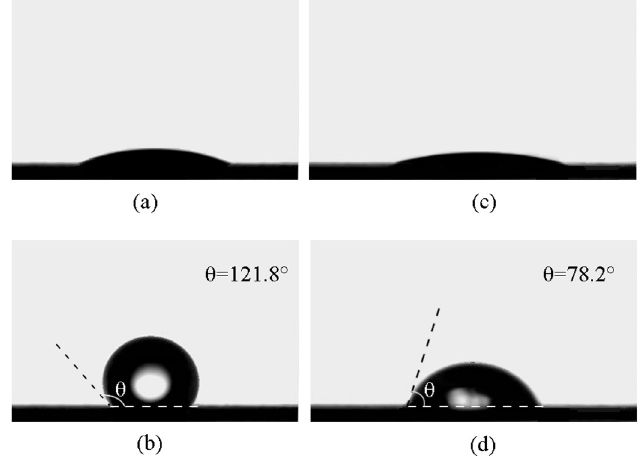
Figure 7. Contact angle test of water and ethylene glycol on inkjet paper before and after coating (( a )—Contact angle of the coating film without fluorine to water. ( b )—Contact angle of coating film with fluorine element to water. ( c )—Contact angle of the coating film without fluorine to ethylene glycol. ( d )—Contact angle of coating film with fluorine element to ethylene glycol).